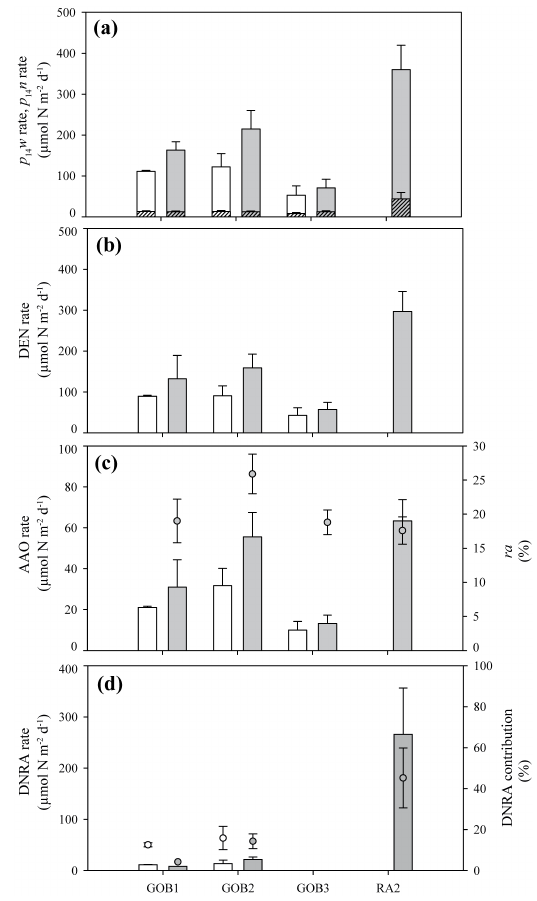
Figure 6. Average rates of NO − x -reducing processes measured at the four stations by in situ incubations with benthic chamber lan- ders amended with 15 N-nitrate, where white and grey bars represent 2013 and 2014 rates, respectively, with associated standard errors: (a) hatched bars represent rates of N 2 production depending on the water column nitrate ( p 14 ), while unhatched bars represent rates w of N 2 production coupled to nitrification ( p 14 ); (b) bars represent n total denitrification (DEN) rates; (c) bars represent total anammox (AAO) rates and refer to the left y axis, while grey dots represent percentages of ra and refer to the right y axis; and (d) bars repre- sent total DNRA rates and refer to the left y axis. White and grey dots represent contribution of DNRA to total nitrate reduction (DEN rate + DNRA rate) and refer to the right y axis for year 2013 and 2014, respectively. DNRA rates at GOB3 were not